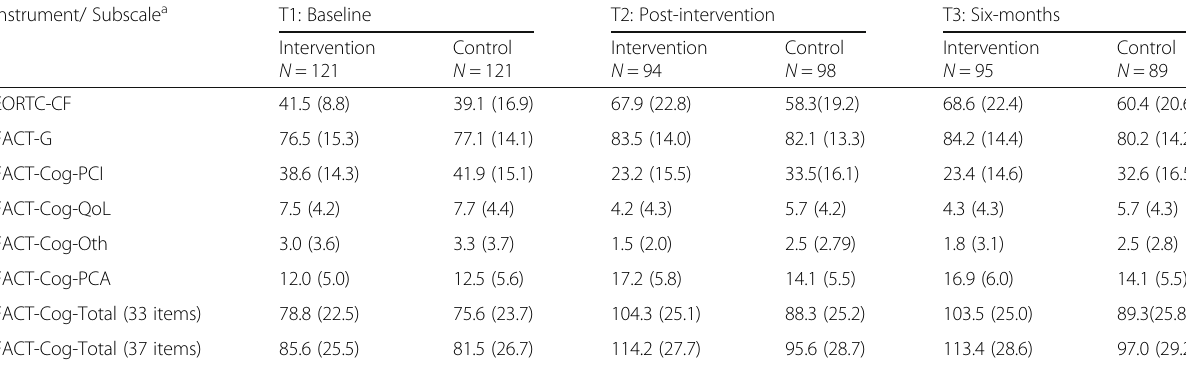
Table 2 Means and SDs for each of the FACT-Cog subscales and total scores, at each of the time points, by treatment arm Instrument/ Subscale